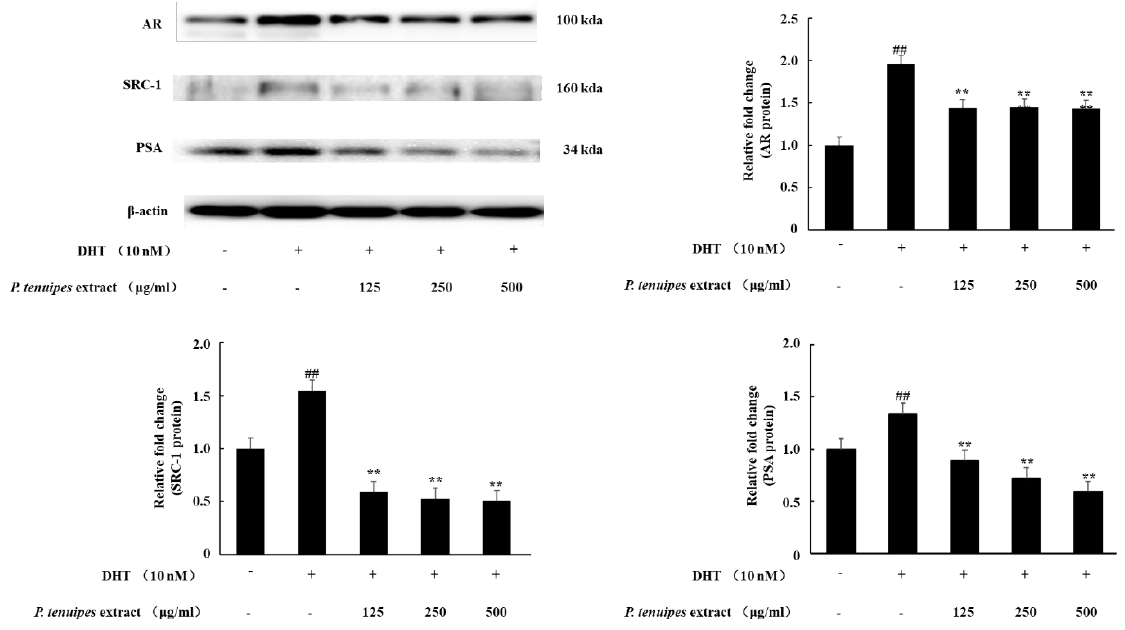
Figure 1. Western blotting analysis of androgen receptor (AR), steroid receptor coactivator 1 (SRC-1), and prostate specific antigen (PSA) expressions in the LNCaP cells. LNCaP cells were incubated in the medium containing dihydrotestosterone (DHT; 10 nM) and P. tenuipes extract (PE; 125, 250, or 500 µ g / mL) for 24 h. Then, cell lysates (30 µ g) were assayed for the expression levels of AR, SRC-1, and PSA by Western blotting. Data are representative of three independent experiments; data are expressed as the means ± SEM. Note: ## p < 0.01 compared with the DHT non-treated group; ** p < 0.01 compared with only the DHT treated